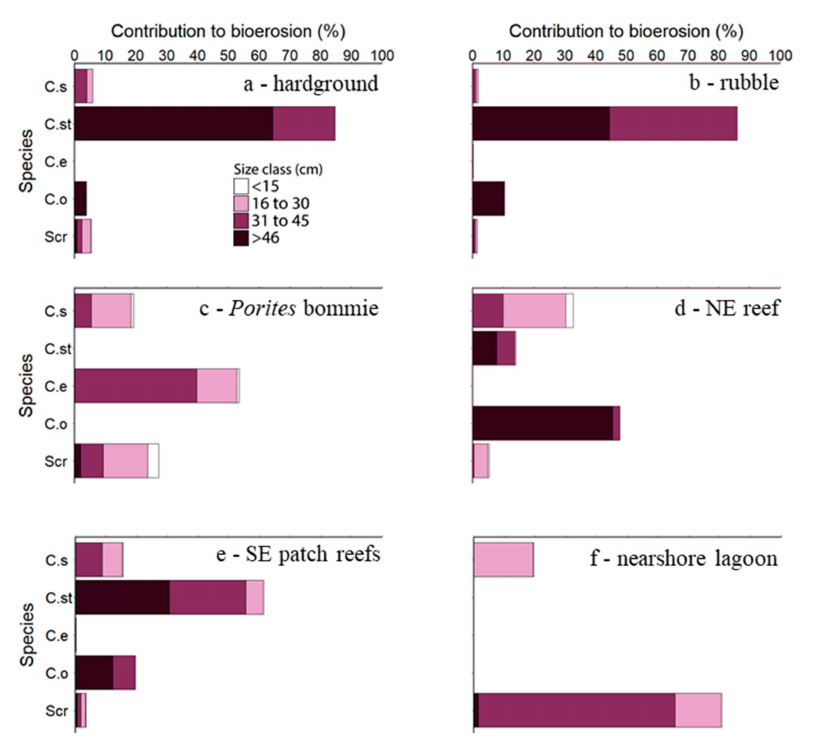
Figure 2. Percent contributions to total parrotfish bioerosion by four size classes of the fifteen species present in the six Vavvaru habitats supporting parrotfish. Species abbreviations: C. s— Chlorurus sordidus , C. st— C. strongylocephalus , C. e— C. enneacanthus , C. o— Cetoscarus ocellatus , Scr—Scrapers